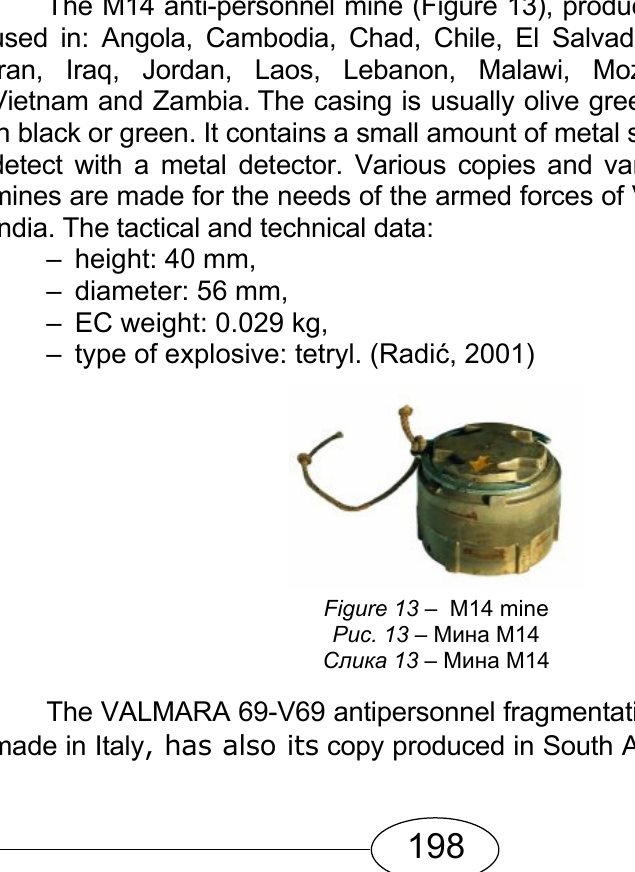
Figure 12 – PRB-M35 mine Рис . 12 - Мина PRB-M35 Слика 12 – Мина PRB-M35